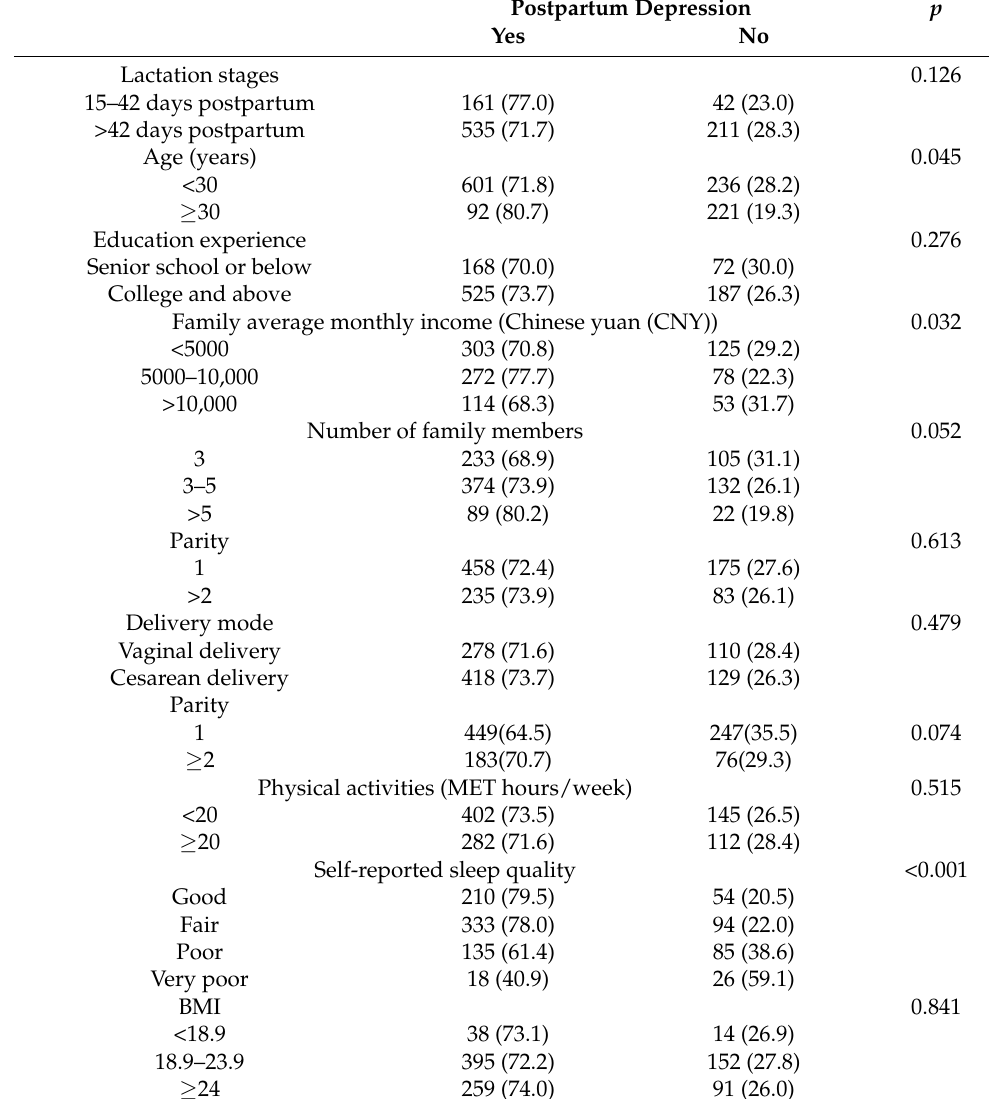
Table 1. Postpartum depression among women with different sociodemographic characteristics ( N , %). Postpartum